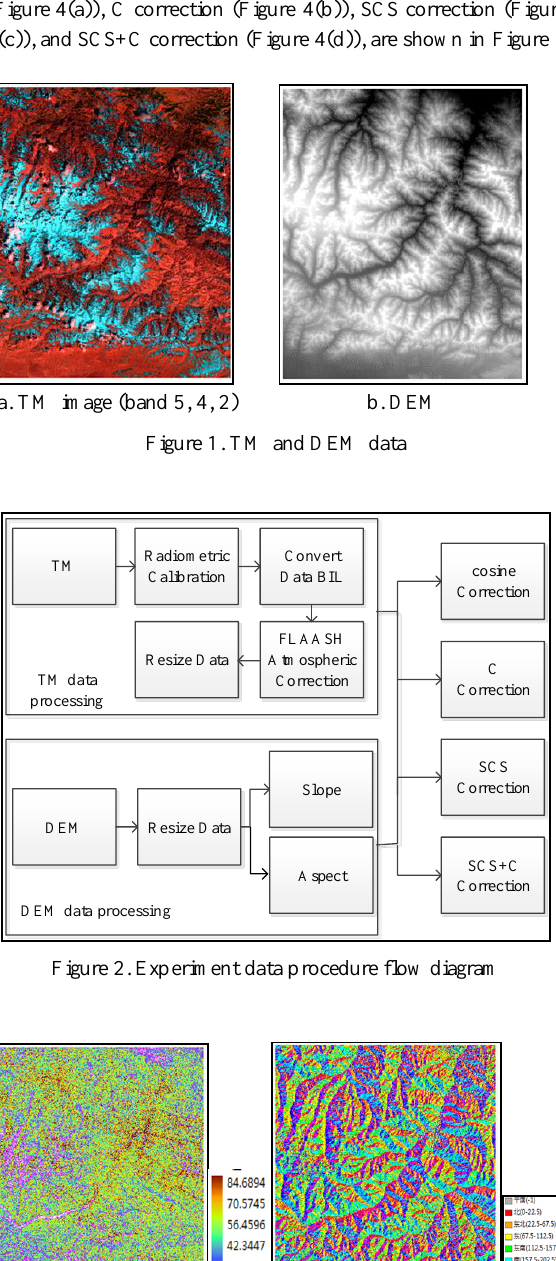
Figure 3. Slope and aspect